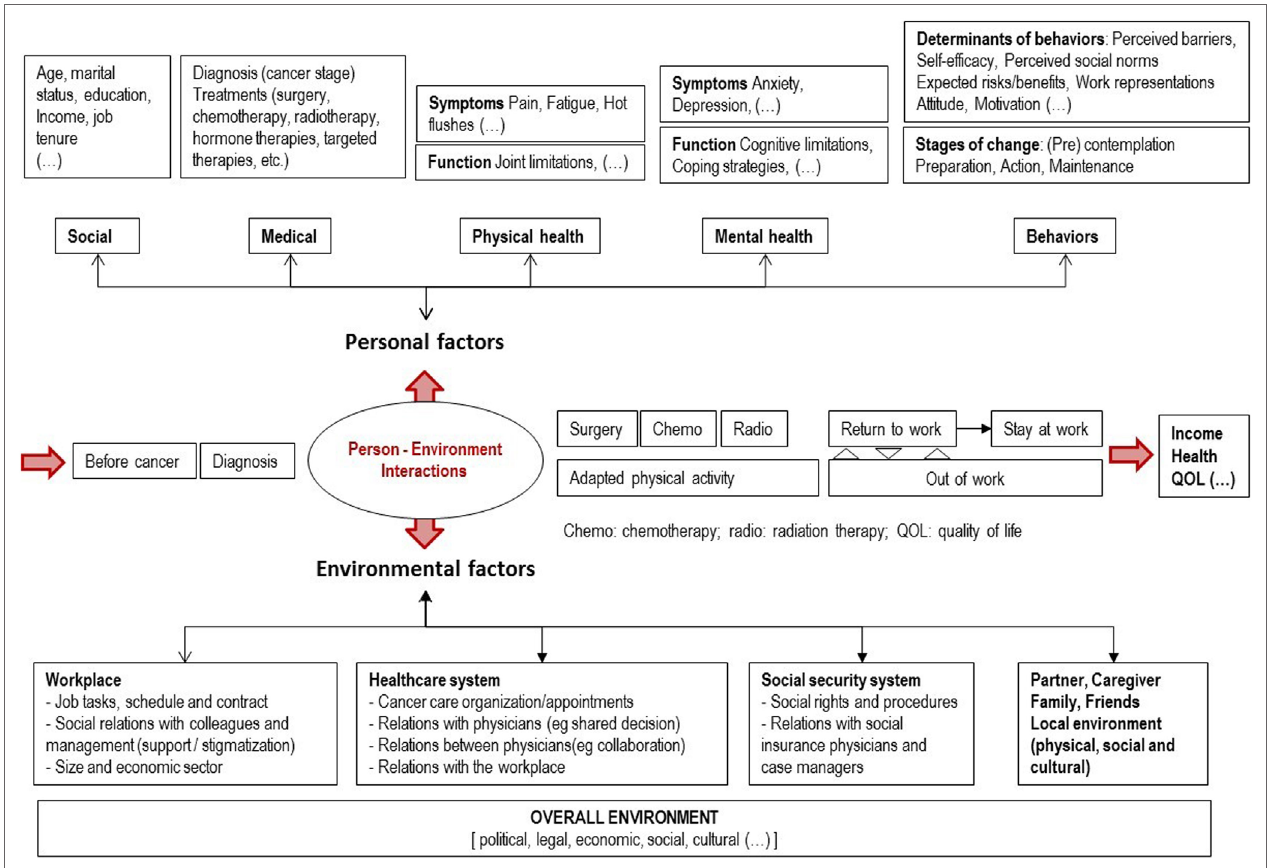
FigUre 1 | Logic model of the